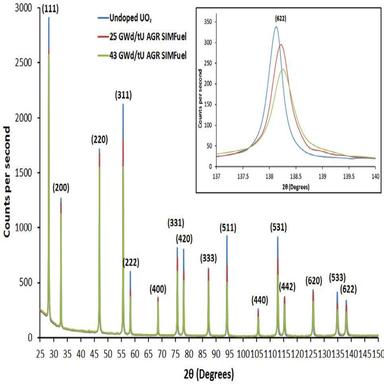
X-ray diffraction patterns of undoped UO2, 25 GWd/tU SIMFuel and 43 GWd/tU SIMFuel pellets (main) and magnification of the (622) reflection peak (inset).